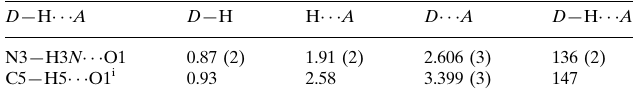
Hydrogen-bond geometry (A˚ , (cid:2)